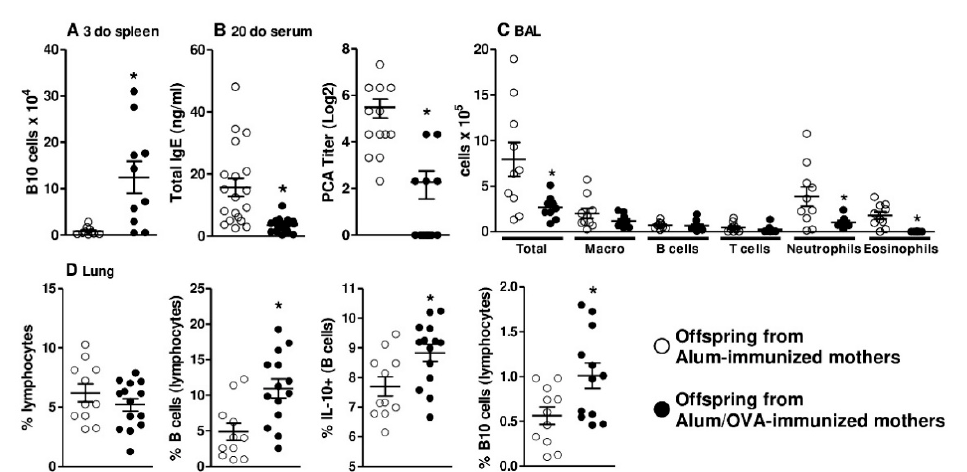
Figure 1. E ff ects of maternal immunization on o ff spring B10 cells, antibody production, and lung inflammation. The number of splenic B10 cells was evaluated in o ff spring from Alum-immunized ( n = 10) or Alum / OVA-immunized ( n = 10) mothers ( A ) Pups from both groups ( n = 13–19 pups in each group; pups were delivered from four or five mothers in each group) were immunized with ovalbumin (OVA) in the neonatal period and evaluated at 20 days old (d.o). Total IgE levels were determined by ELISA, and anaphylactic IgE was determined by PCA ( B ) Bronchoalveolar fluid (BAL) preparation and dissociation of o ff spring lungs ( n = 10–14 in each group) were performed on 60-d.o. o ff spring after five intranasal challenges. The di ff erential cell counts in BAL were evaluated by flow cytometry ( C ). The dissociated lungs were evaluated by flow cytometry ( D ) Data are presented as each individual value, mean ± SEM. * p ≤ 0.05 compared with the Alum-immunized groups using Mann–Whitney U test.